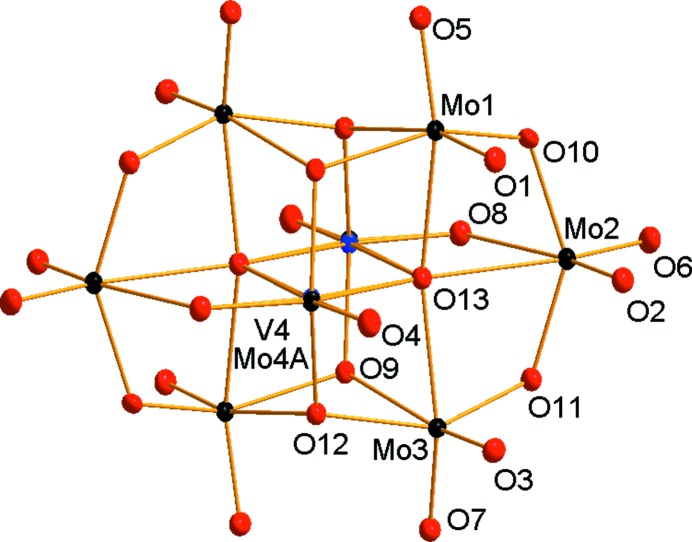
The mol­ecular structure of [VMo7O26]5− in VMo7, showing the atom-labelling scheme. Displacement ellipsoids are shown at the 50% probability level. Colour code: Mo black, V blue and O red.